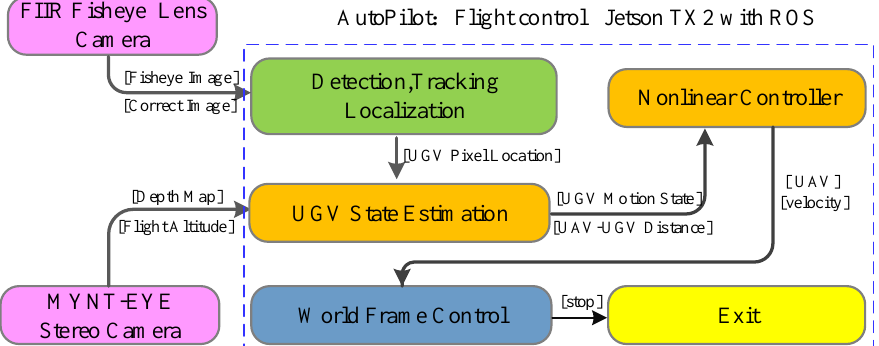
Figure 2. The control architecture diagram of the proposed system. It shows the data transmission from the hybrid camera array to the target location and state estimation, then to a nonlinear